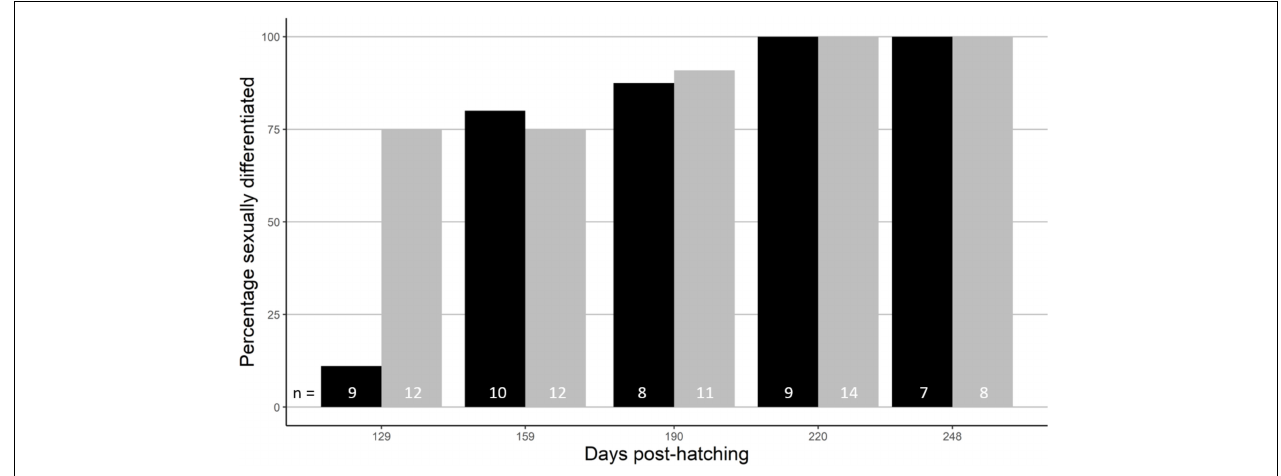
FIGURE 2 | Timing of sex differentiation in males (black) and females (grey). The sample sizes are given at the bottom. See Table 2A for statistics.